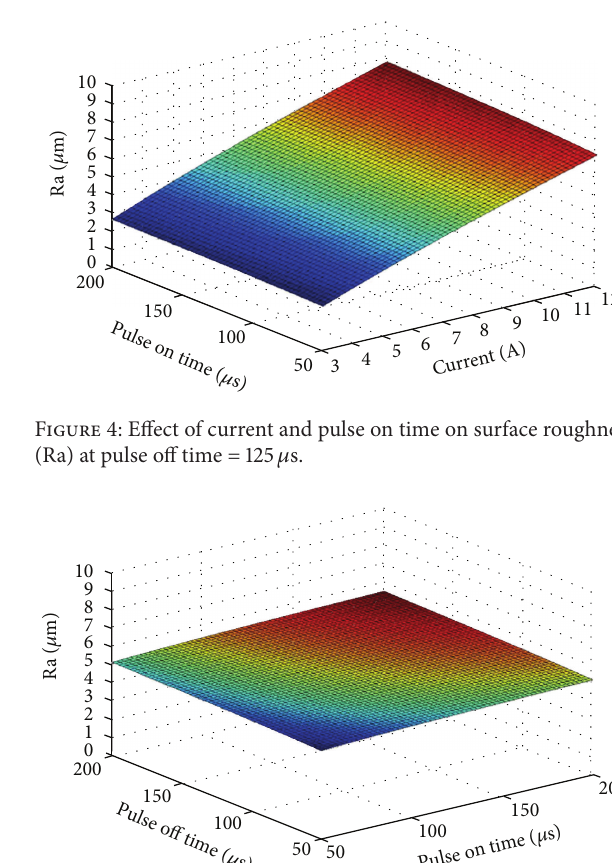
Figure 5: Effect of pulse on time and pulse off time on surface roughness (Ra) at current = 7.5